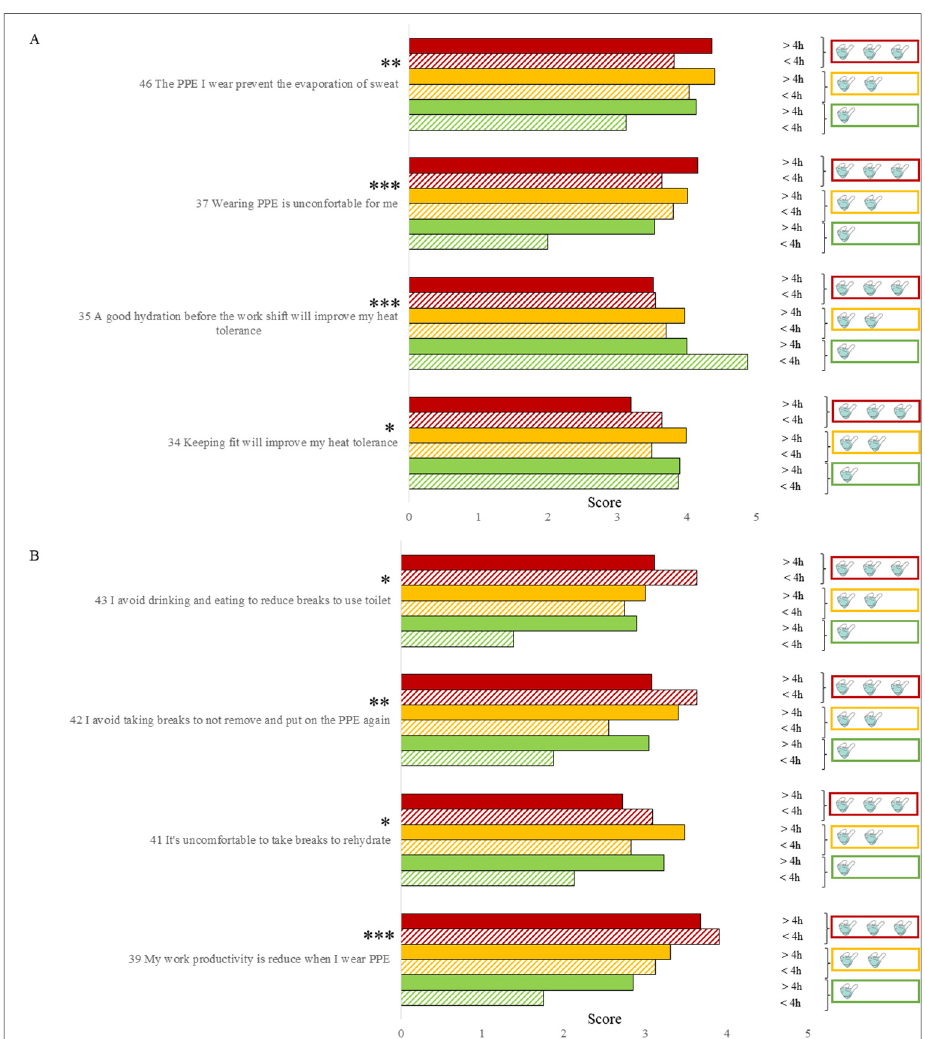
Figure 3. ANOVA to evaluate the effect of the use of the masks on the answers related to items 34, 35, 37 and 46 ( A ) and items 39, 41, 42 and 43 ( B ). Different kind of masks (from 1 up to 3 kind) and different time of use (<4 h or >4 h) was considered. A 5-point Likert scale (1 for strongly disagree and 5 for strongly agree) was used for questions. (Sig): *** p < 0.001; ** p < 0.01; * p < 0.05.